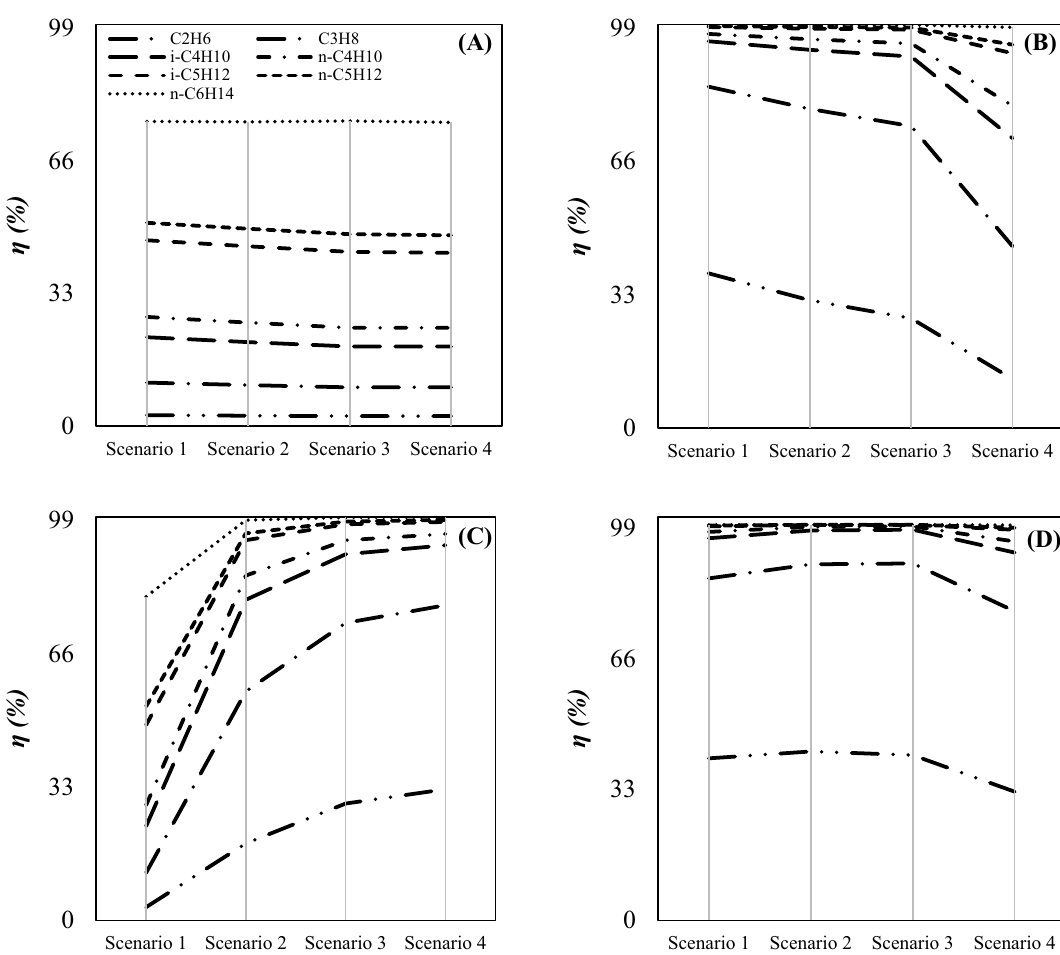
Figure 14. Component collection efficiency for various scenarios and configurations: ( A–D ) correspond to configurations ( A–D ) respectively with dp = 4